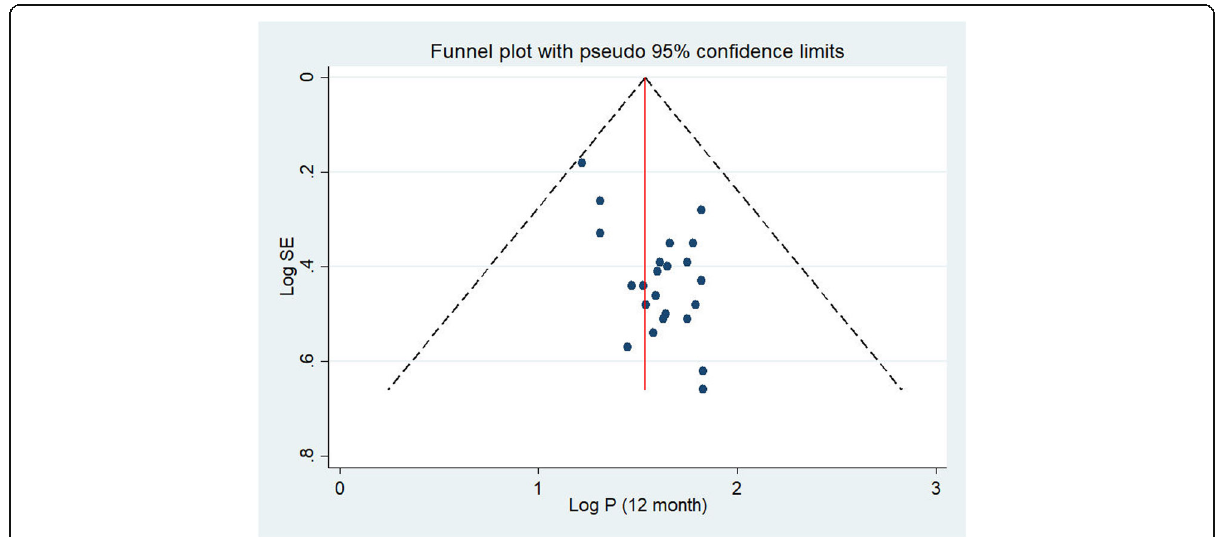
Fig. 4 Publication bias of 12-month prevalence of BBFs exposure among HCWs in Ethiopia, 2007-2020